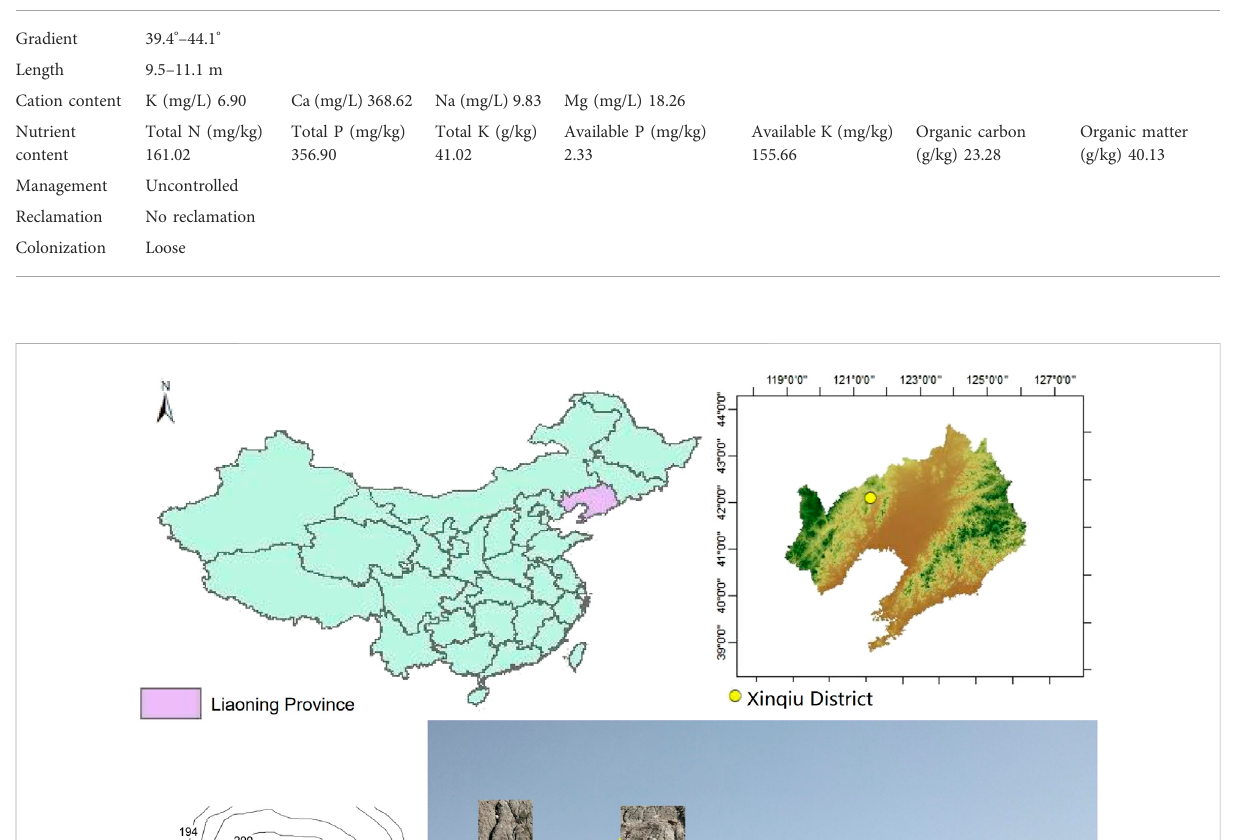
TABLE 1 Basic characteristics of the researched waste dump.